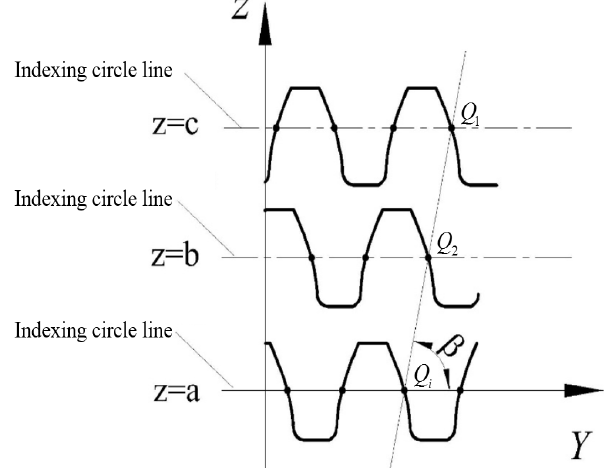
Figure 6. Schematic diagram of the helix angle calculation.